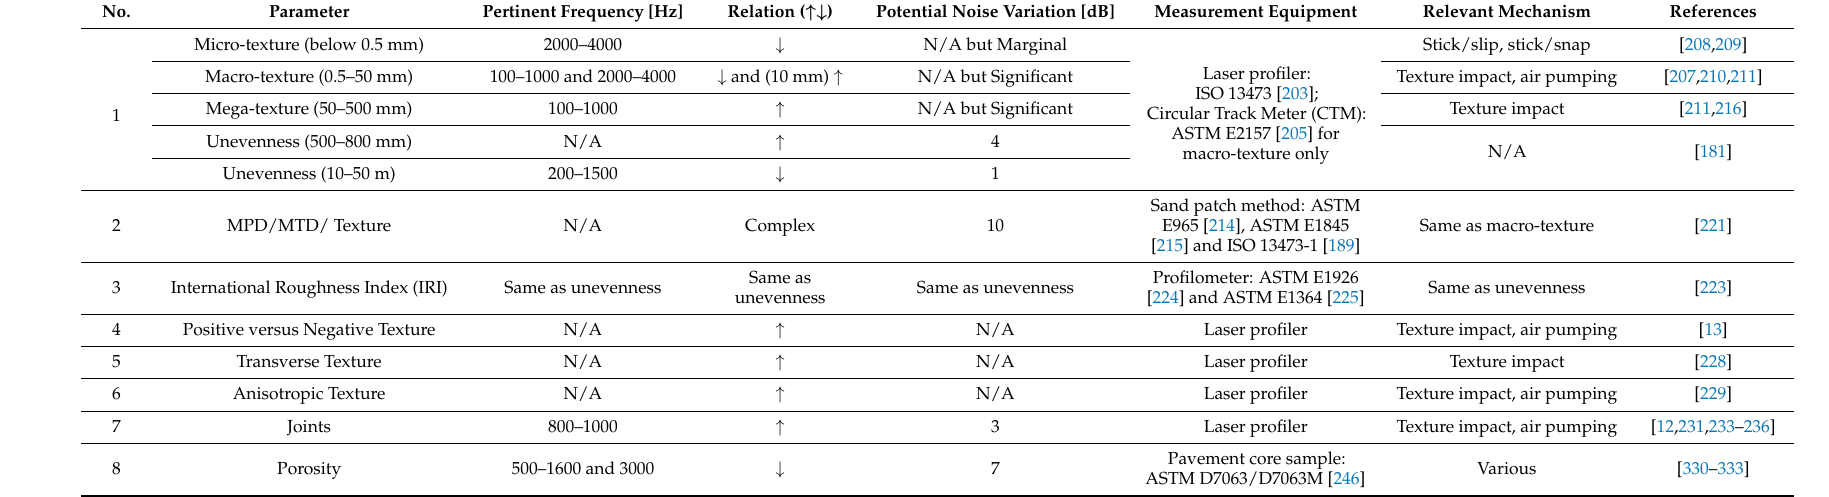
Table 18. Summary of pavement-related parameters affecting